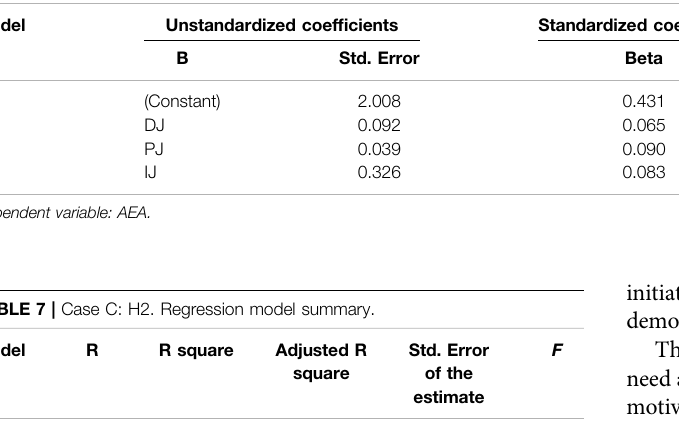
TABLE 6 | Case B: H2. Coef fi cients.